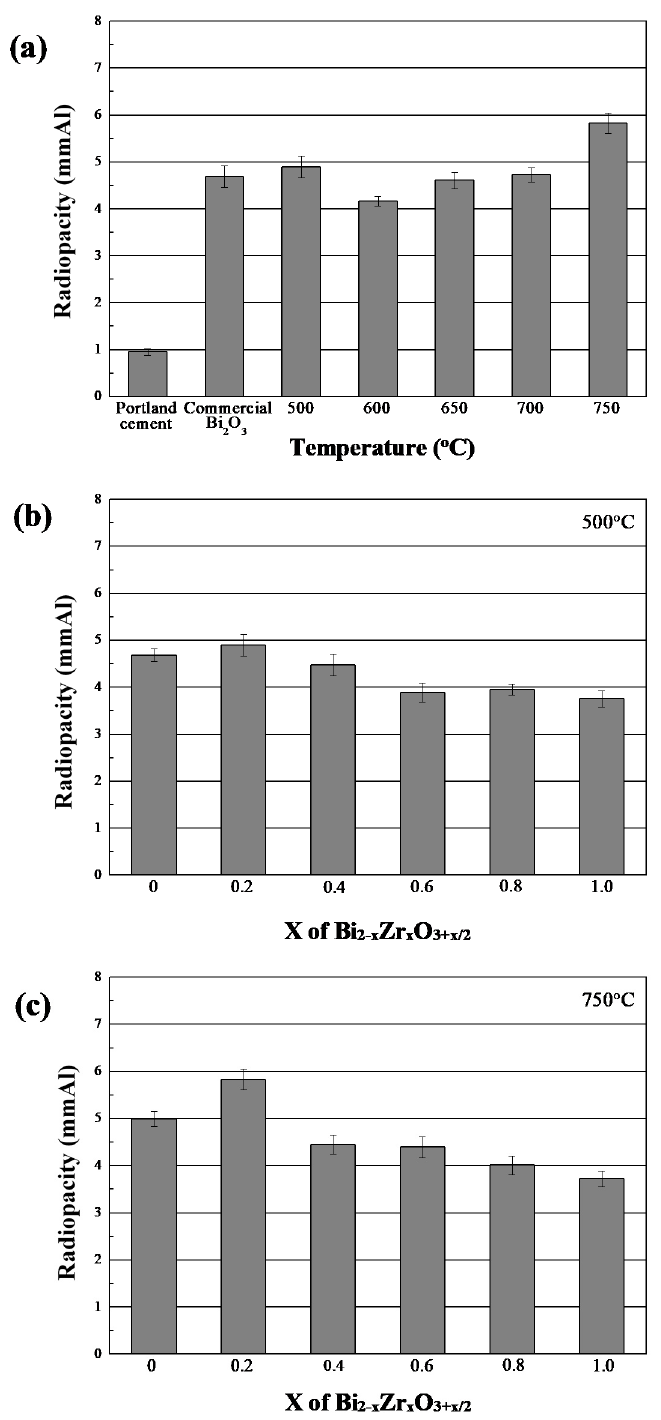
Figure 11. ( a ) Comparison of radiopacity of heat-treated Bi 1.8 Zr 0.2 O 3.1 powders and